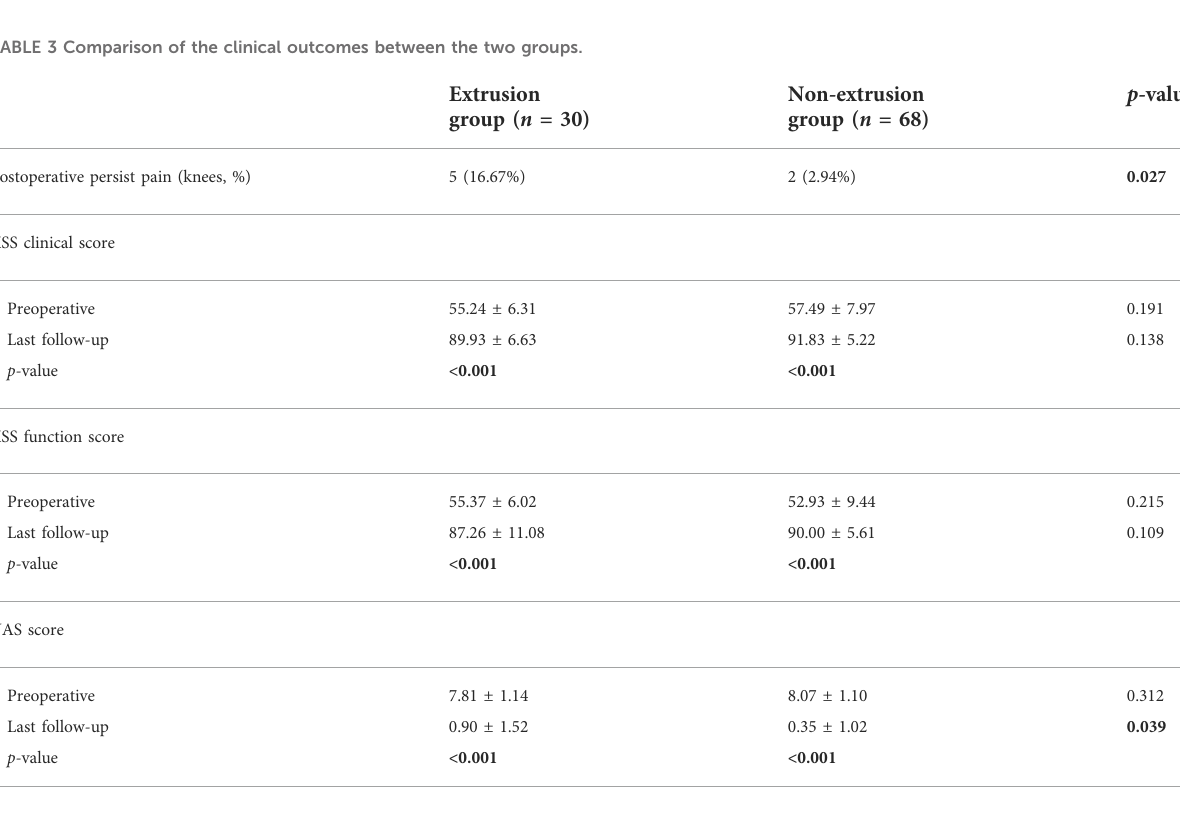
TABLE 3 Comparison of the clinical outcomes between the two groups.